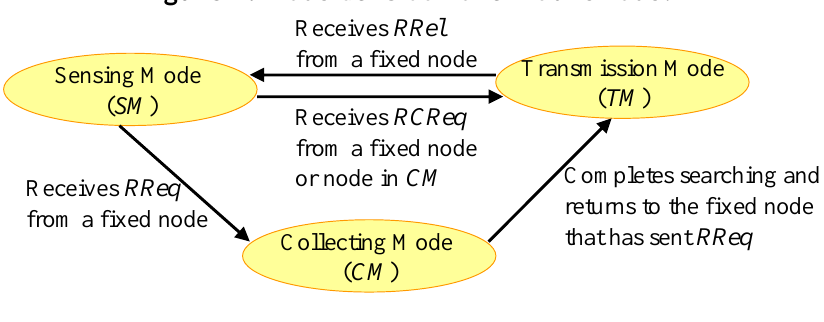
Figure 1. Mode transition of a mobile